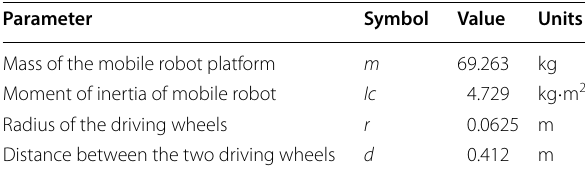
Table 1 Parameters used in the